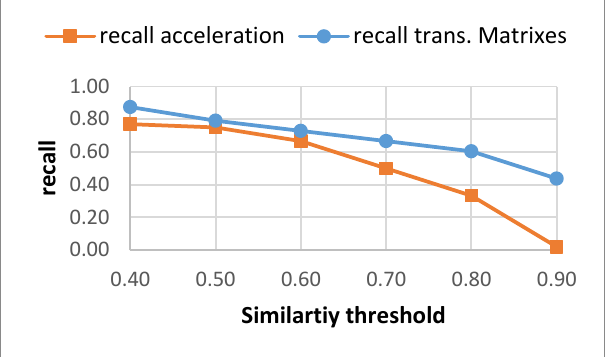
Figure 3. Recall for different similarity threshold for both methods.